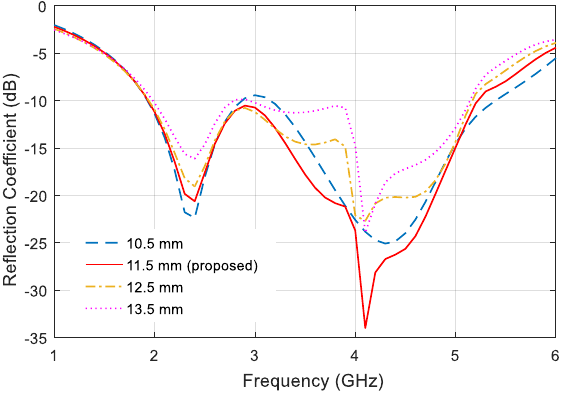
Figure 2. Return loss variation versus frequency for different values of w 1.